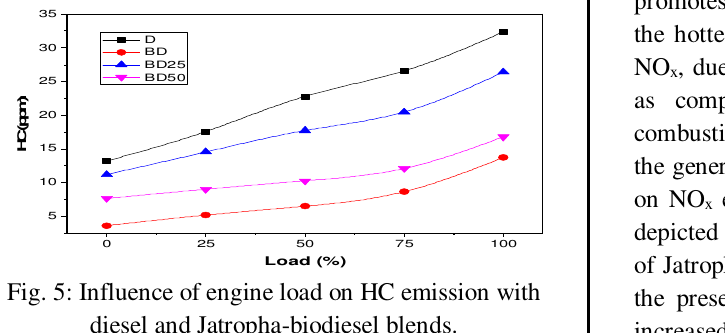
Fig. 5: Influence of engine load on HC emission with diesel and Jatropha-biodiesel blends.